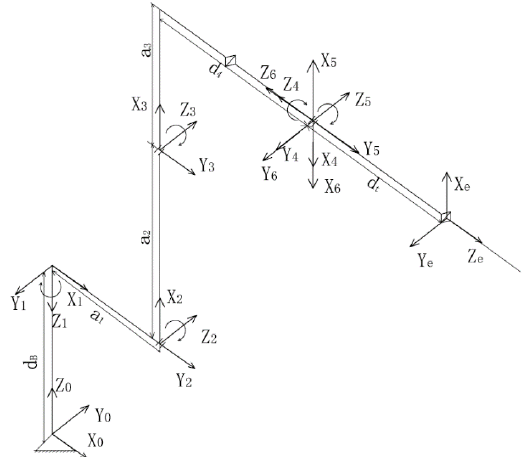
Figure 2. D-H coordinate system. (Notes: The distance between these two normals was d i .θ i , which is the angle between two connecting rods; d i is the distance between two links; a i is the length of the connecting rod; and α i is the torsion angle of the connecting rod.)